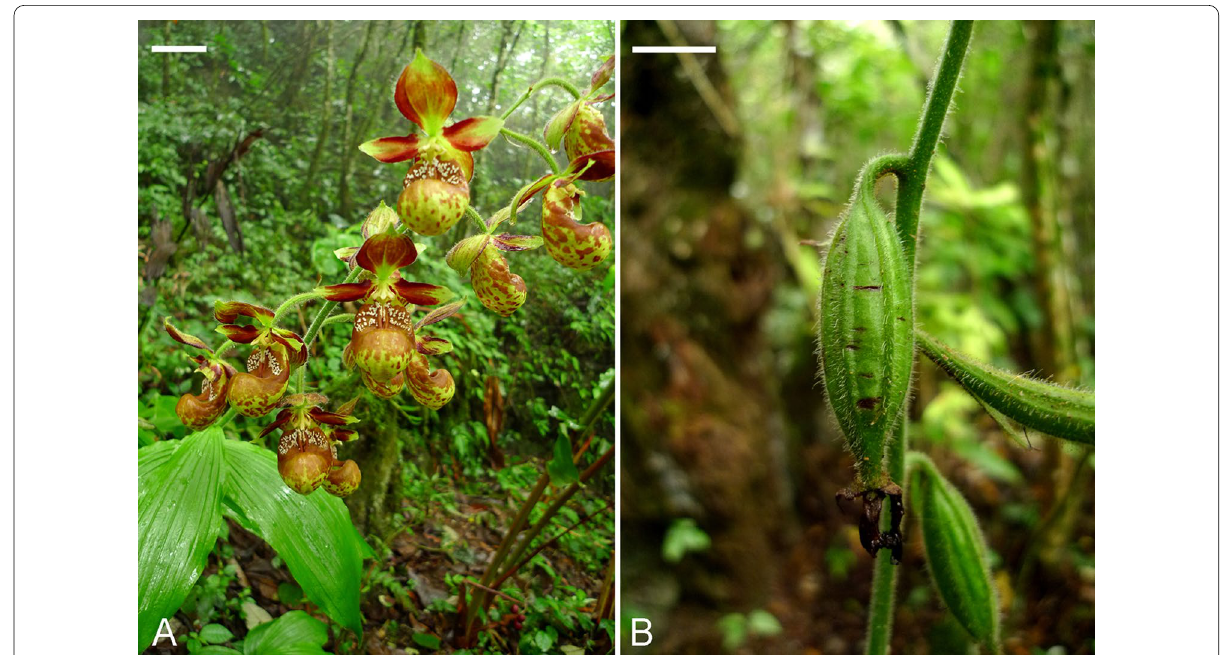
Fig. 1 A Flowers of C. subtropicum . Scale bar